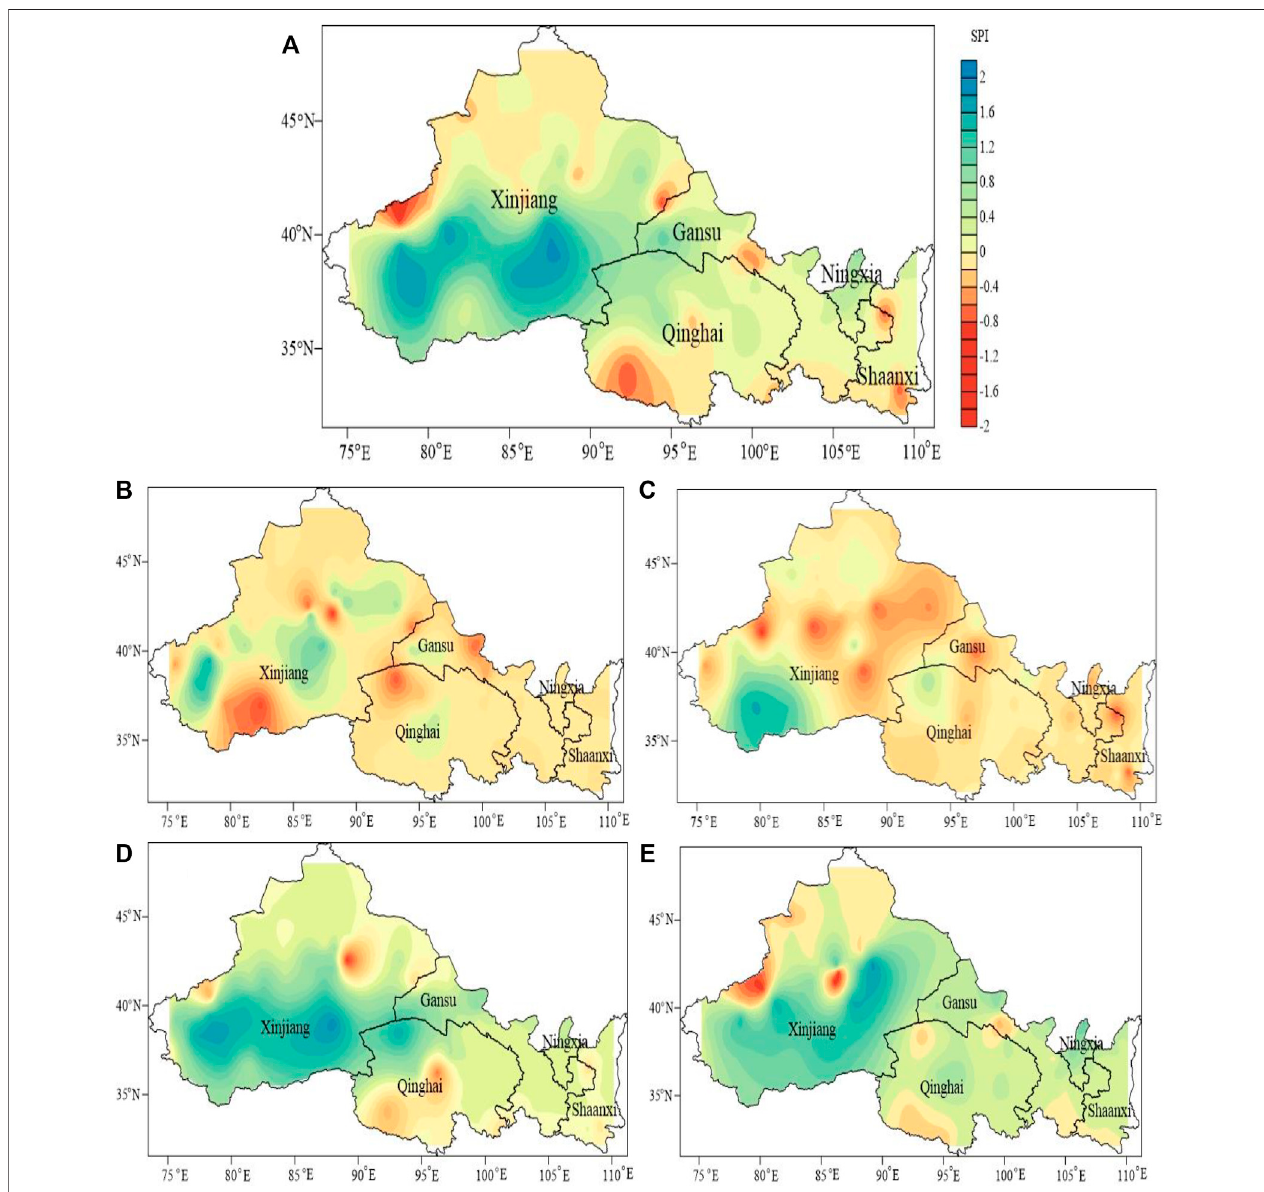
FIGURE 5 | Spatial distribution of average SPI from 1960 to 2018 in